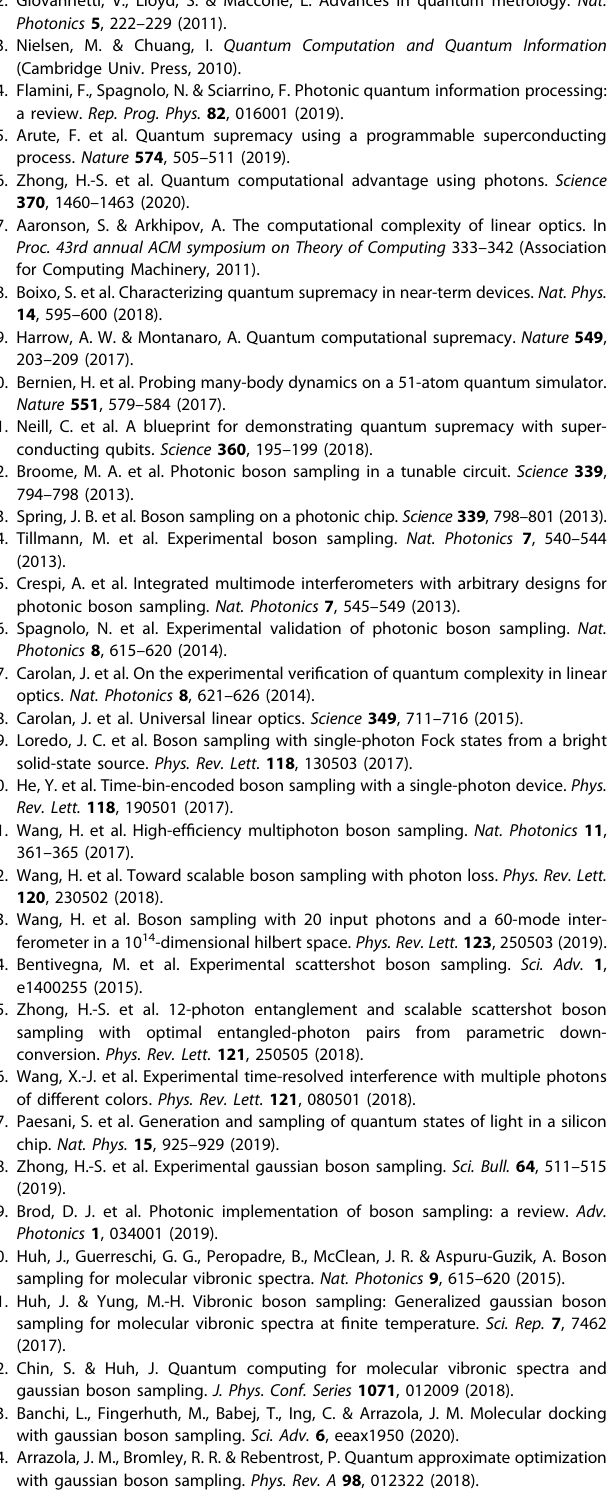
Algorithm 1 . The second algorithm reported in ref. 42 , which